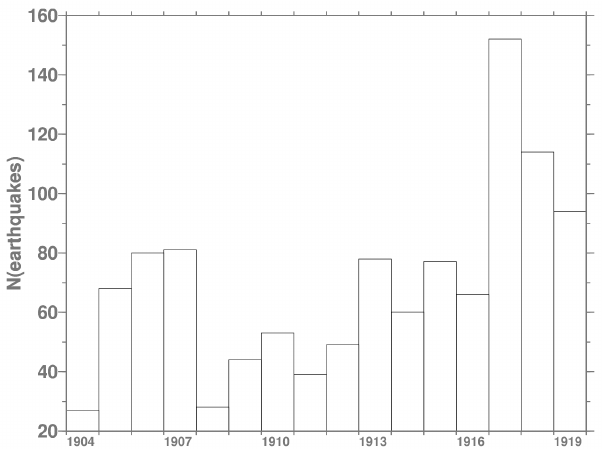
Figure 15. Annual number of relocated extension events between 1904 and 1919. See text for